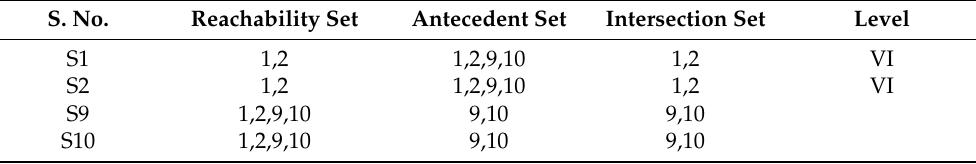
Table A6. Level partitions (Iteration